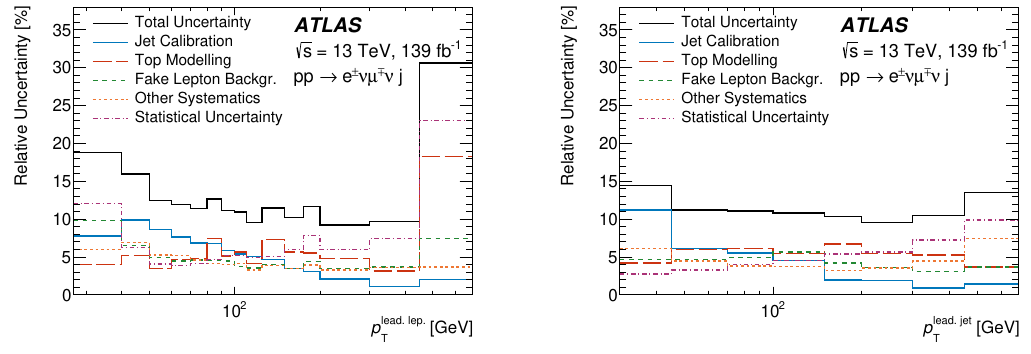
and p lead. jet distributions. T T